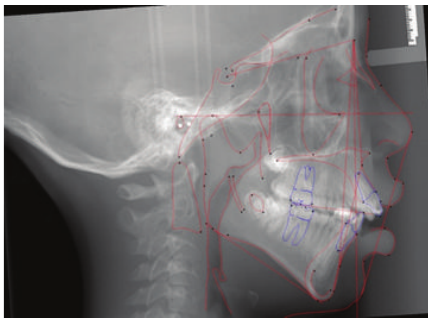
Figure 5: Initial cephalometric radiograph.